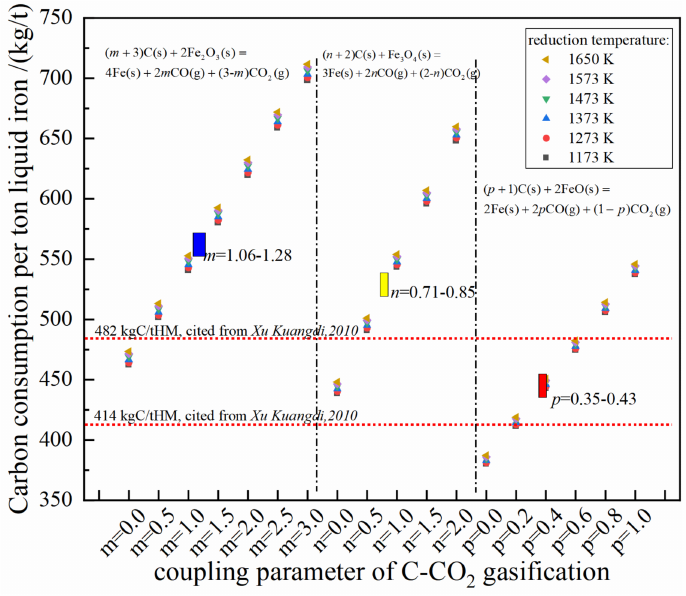
Figure 18. The carbon consumption per ton of liquid iron of varied coupling reactions. Table 9. The carbon consumption for coupling reactions per ton liquid iron (kg C/t). Reaction